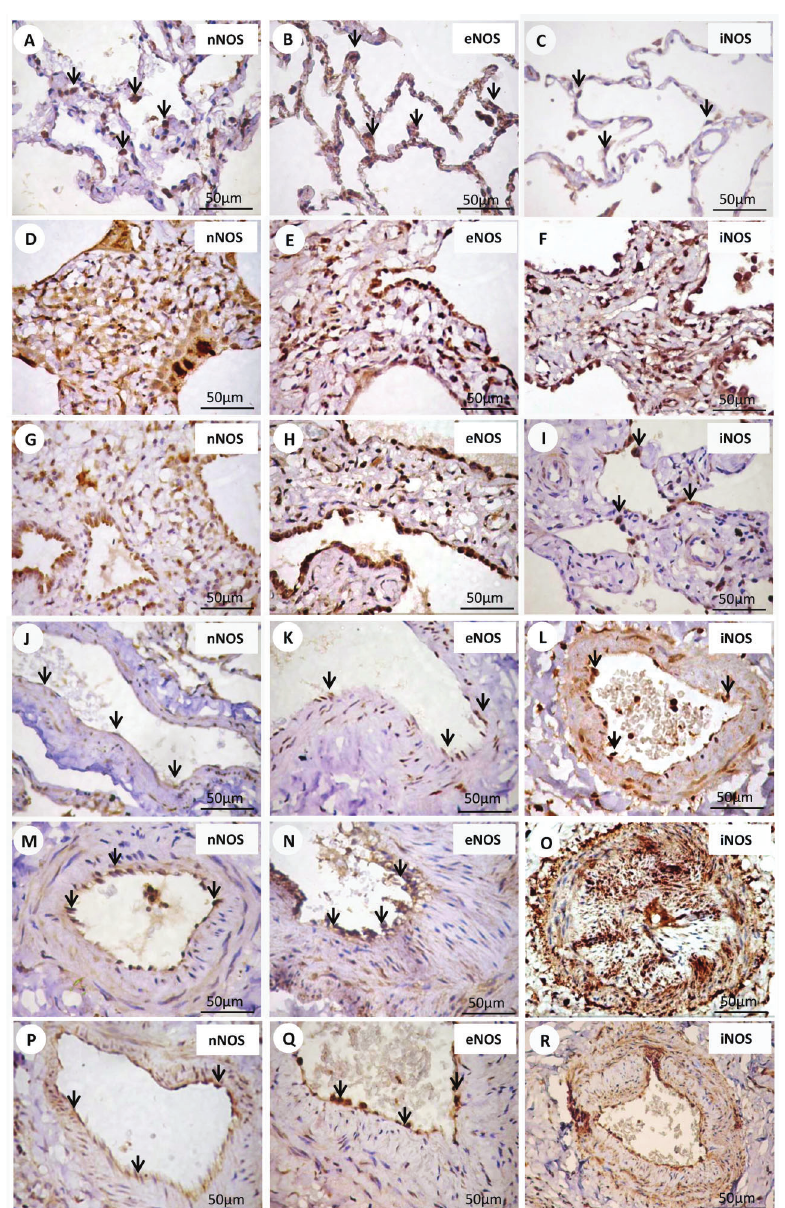
Figure 1. Immunohistochemical staining with nNOS, eNOS and iNOS. Cell expressions of nNOS, eNOS and iNOS in septal interstitium and intrapulmonary vessels from normal and systemic sclerosis (SSc) lung tissue are shown. There is a diffuse and increased expression of nNOS ( D ), eNOS ( E ) and iNOS ( F ) in the septal interstitium of patients with cellular nonspecific interstitial pneumonia (NSIP) compared with nNOS (arrows) ( A ), eNOS (arrows) ( B ) and iNOS (arrows) ( C ) of the control group and more than nNOS ( G ), eNOS ( H ), and iNOS ( I ) of fibrotic NSIP. An increased expression of iNOS in vessels of cellular NSIP ( O ) and fibrotic NSIP ( R ) is observed when compared with control ( L ). Similar expression of nNOS and eNOS is observed comparing nNOS (arrows) ( M ) and eNOS (arrows) ( N ) in vessels of cellular NSIP and nNOS (arrows) ( J ) and eNOS (arrows) ( K ) of control and nNOS (arrows) ( P ) and eNOS (arrows) ( Q ) of fibrotic